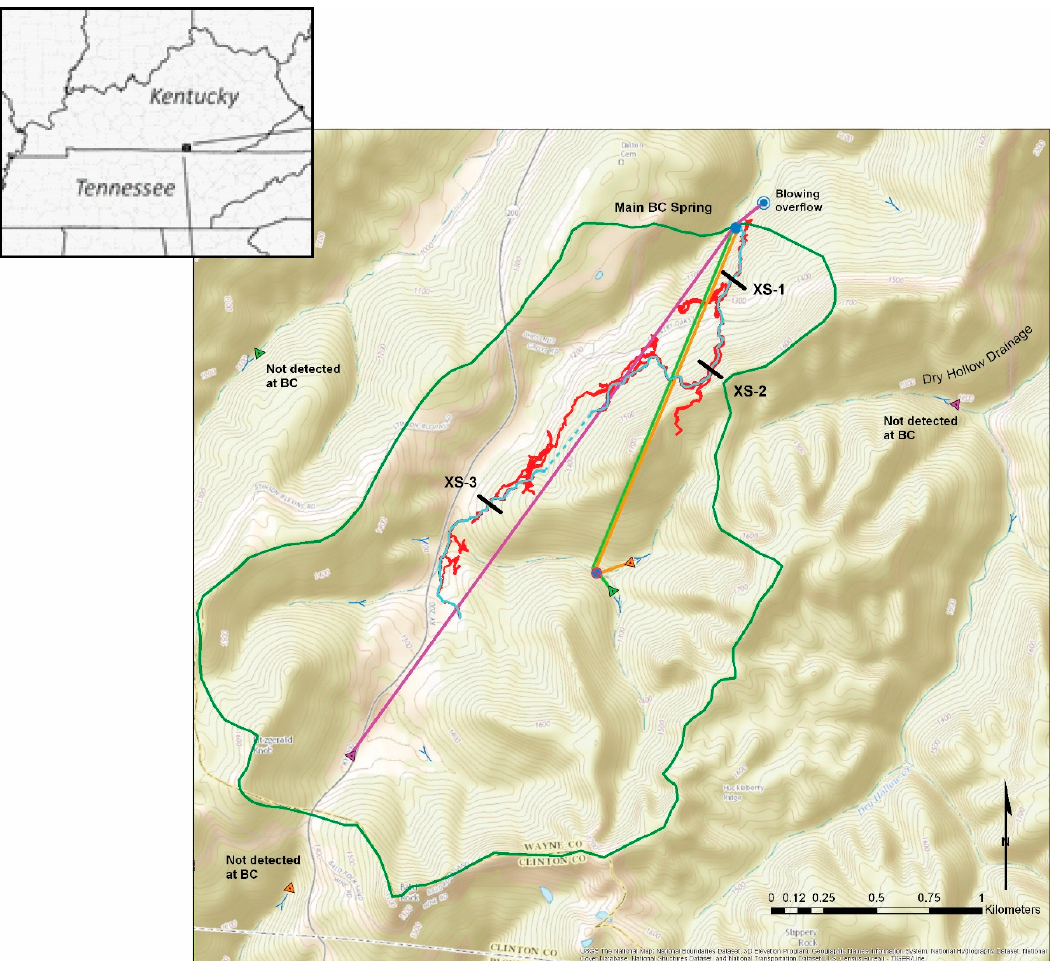
Figure 1. Index map showing Kentucky and Tennessee with black box showing location of Blowing Cave (BC) basin. Map shows outline of basin (green), cave stream (blue), cross sections (XS-1, XS-2, and XS-3), other cave passages (red), dye traces (straight magenta, yellow, and green lines), and dye injection points (triangles) with notation about recovery. Base maps provided by Kentucky Geological Survey, USGS basemap, and Kentucky Speleological Survey. Approximate location of Main BC Spring is 36.647 and − 84.971.